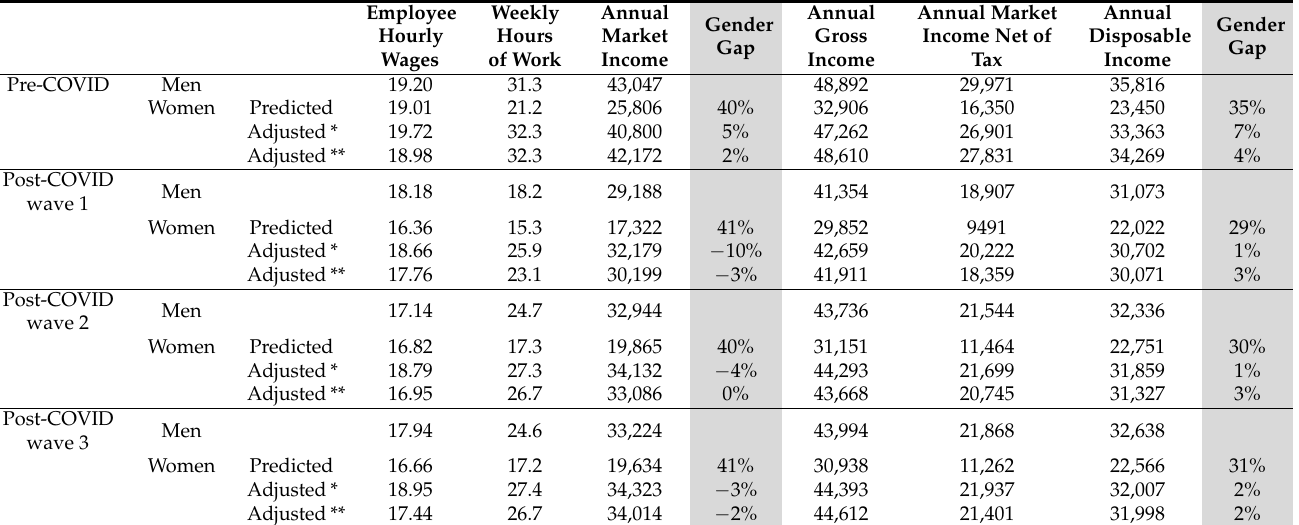
Table 2. Wages, hours of work in income in pre- and post-COVID scenarios and in counterfactual scenarios for